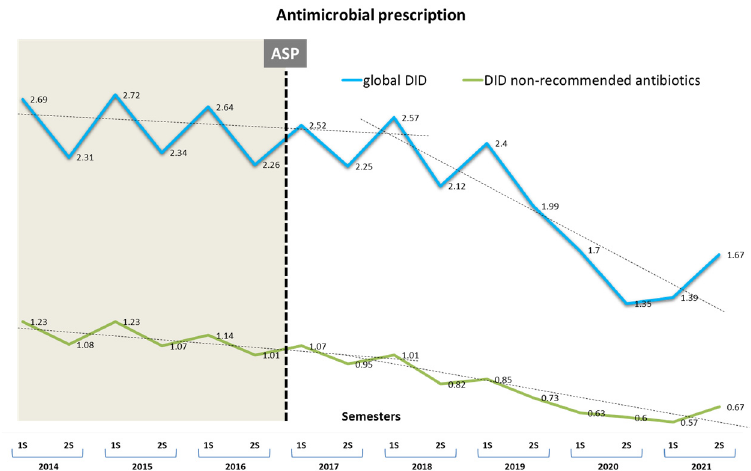
Figure 2. Semestral evolution of defined daily doses per 1000 inhabitants/day (DID). Global antimi- crobial prescription (upper line) and non-recommended antimicrobials (NRA) (lower line). Shaded area represents the pre-antibiotic stewardship program (ASP) intervention period.